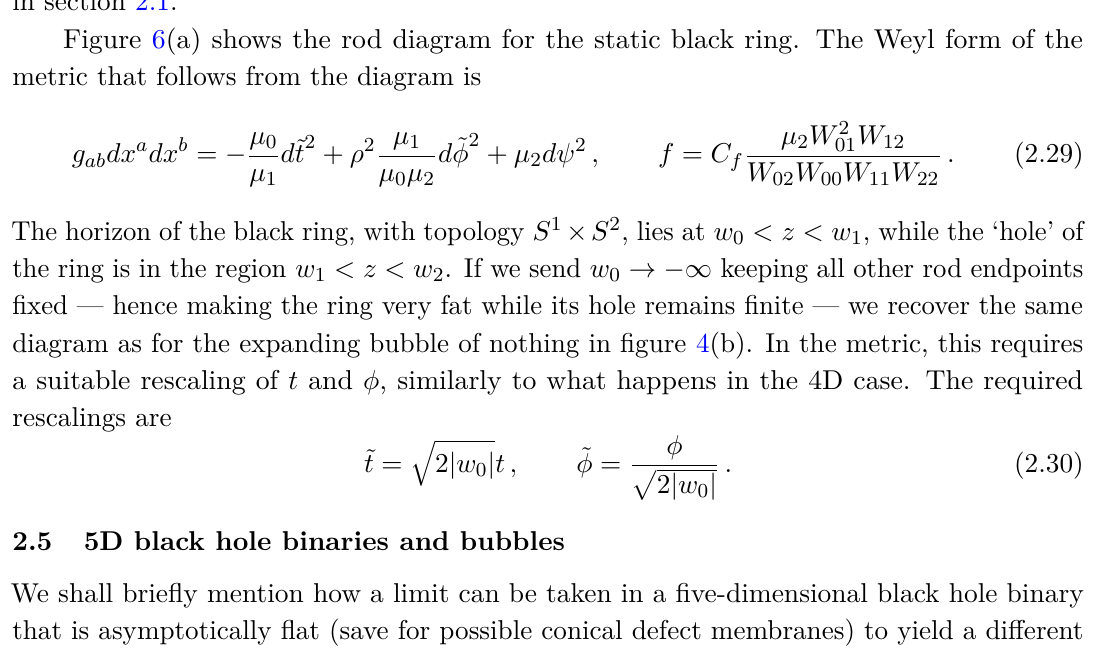
Figure 6 . ( a ) Rod diagram for the static black ring. The thick timelike rod represents the black ring horizon, with topology S 1 fixed, we recover the bubble of nothing in figure 4(b). This limit makes the black ring very fat, while keeping its hole finite, as was illustrated in figure